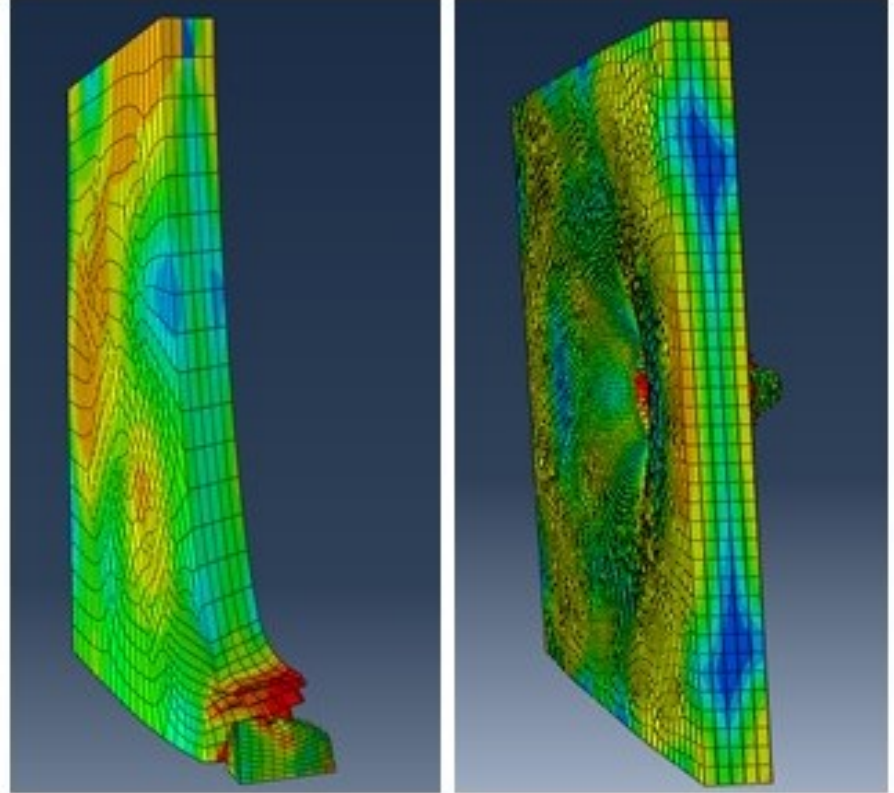
Figure 7. Symmetry Reduced versus Full Scale Model Impact